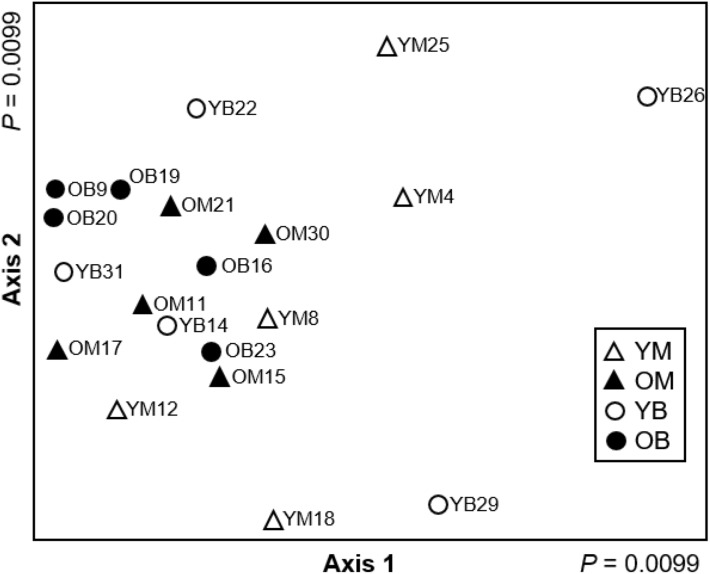
Non-metric multidimensional scaling ordination (stress = 0.088) based on Hellinger transformed abundance of saproxylic Diptera species in decaying wood in southern Quebec.The two axes of a two-dimensional solution are plotted. Young maple (YM; open triangles), old maple (OM; closed triangles), young beech (YB; open circles) and old beech (OB; closed circles).